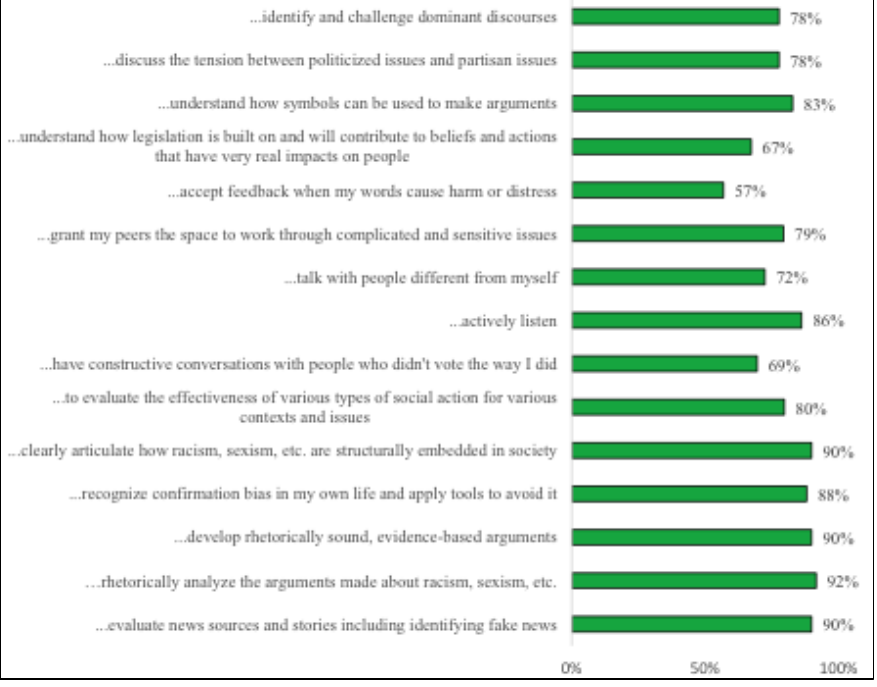
FIGURE 2: COMBINED STUDENT RESPONSES OF “STRONGLY AGREE,” “AGREE” AND “SOMEWHAT